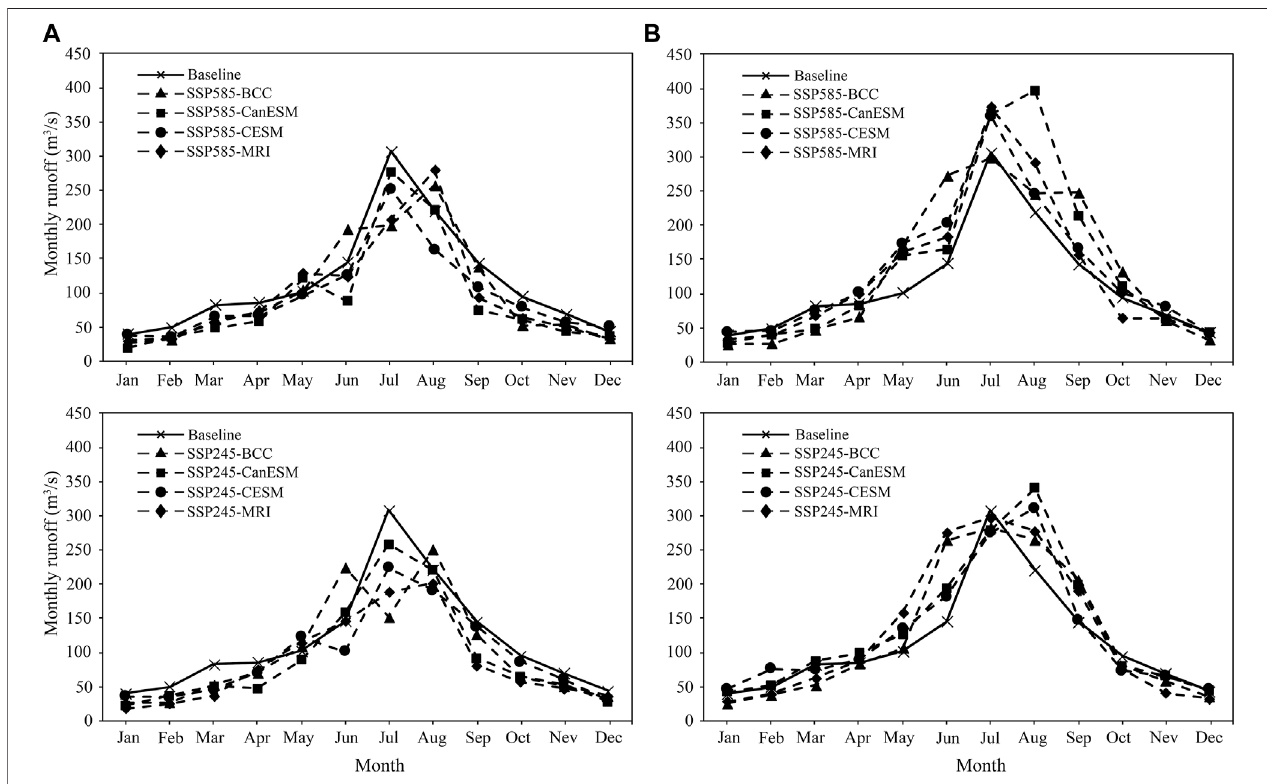
FIGURE 7 | Seasonal runoffs of different GCMs under SSP245 (bottom) and SSP585 (top) scenarios during two future periods 2050s (A) and 2080s (B) . “ Baseline ” denotes the results in the baseline period. “ SSP245_BCC ” denotes the results of BCC model under SSP245 scenario in the future period that as well applies to the other seven abbreviations.